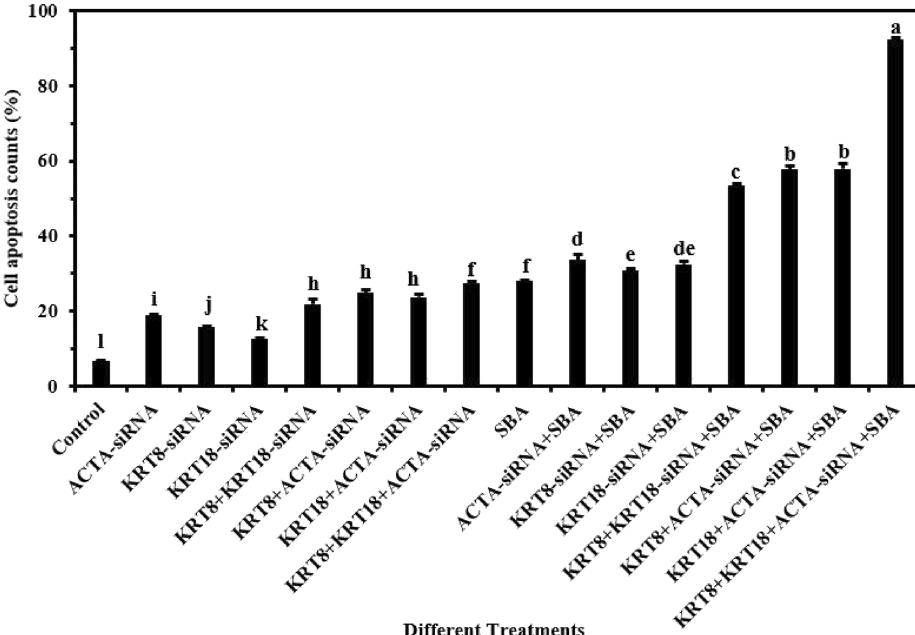
Figure 8. The analysis of cell apoptotic rates in different SBA treatments. Data are presented as mean ± SEM. Different lowercase letters are significantly different ( p < 0.05). In addition, the apoptotic rates of IPEC-J2 in the positive control (T9) were higher than those of silencing one-gene treatments (T2, T3 and T4) and simultaneously silencing two-genes treatments (T5, T6 and T7) ( p < 0.05), but there was no significant difference between T9 and the simultaneously silencing three-genes treatment (T8, p > 0.05). The trend of all cytoskeleton protein-siRNA + SBA treatments was consistent with that of corresponding treatments (simultaneously silencing